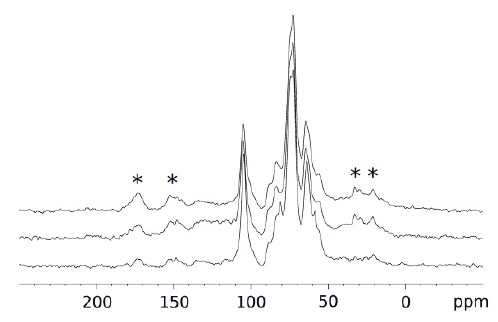
Figure 3. 13 C CP/MAS NMR spectra of raw hay (bottom) and charred hay samples (30 min middle, 60 min top) showing the relative intensity increases in the carboxyl, aryl and alkyl regions (isotropic center bands indicated by *) with charring